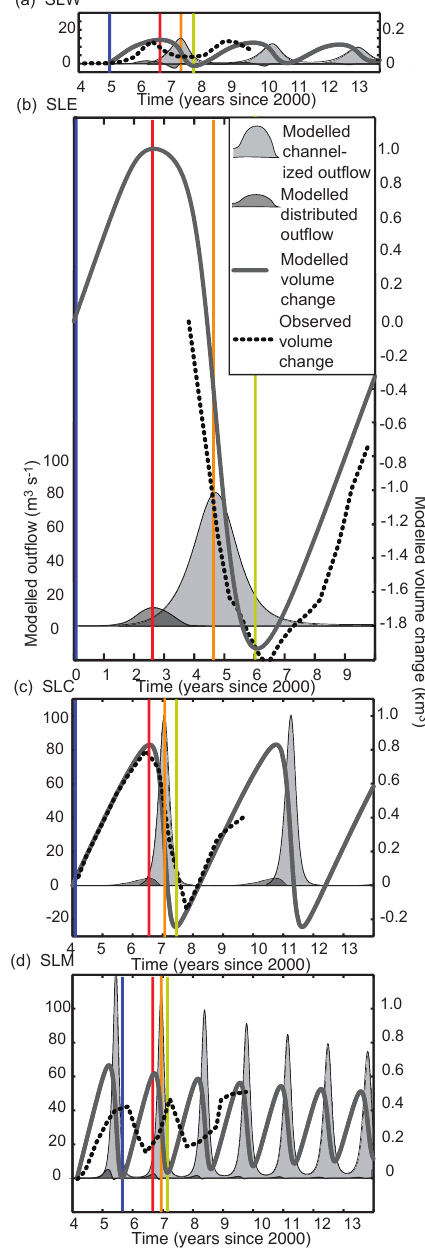
Figure 6. Results of experiments with canal model on the real do- main (Fig. 1b), showing evolution of modeled lake volume and out- flow via distributed (gray) and channelized (blue) systems for con- stant Q in for the four main lakes: (a) SLW, (b) SLE, (c) SLC, and (d) SLM. Also shown are the observed lake volumes from Carter et al. (2013). Colored vertical lines correspond to same time steps from Fig.